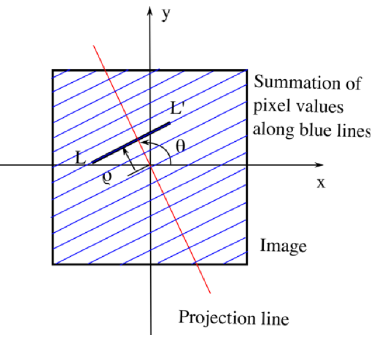
Figure 4. The illustration of Radon Transform, when the projection line is perpendicular to the linear feature LL’, peak occurs in the RT Figure 6. Block processing based on the Radon Transform applied to MCoRDS radar echogram, (a) the original radar echogram; (b) Radon Transform directly applied into original radar echogram; (c) Bilateral filtering of radar echogram;(d) radar echogram after adaptive histogram equalization; (e) edge detection by the Canny algorithm; (f) Radon Transform of (e), showing obvious peaks.